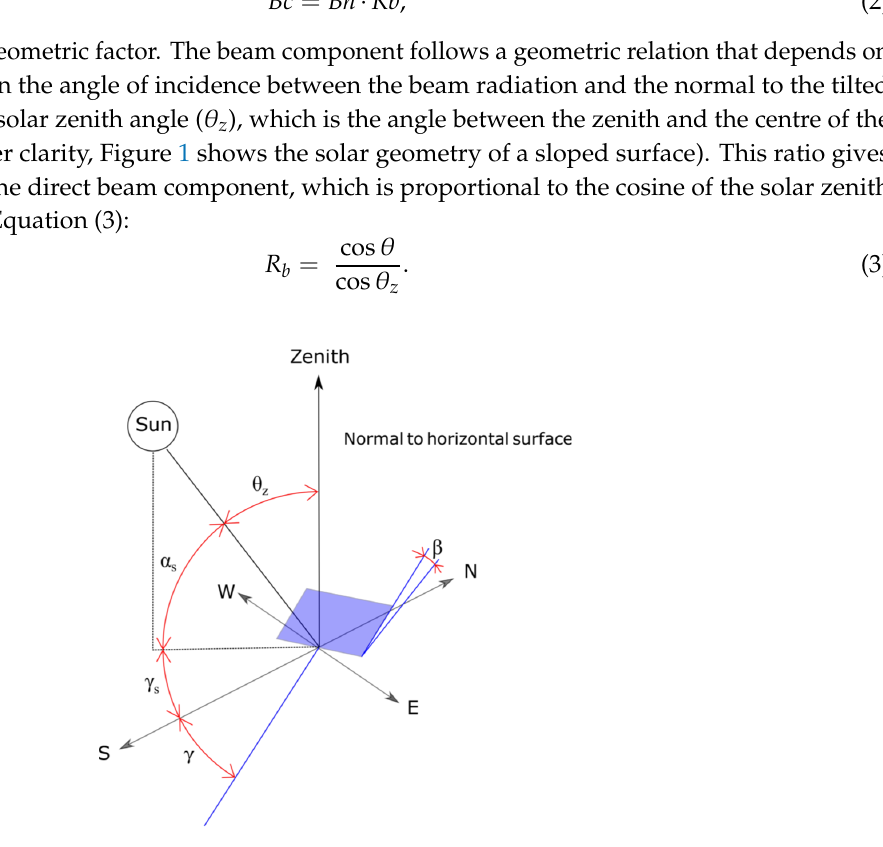
Figure 1. Zenith angle ( θ z ), slope ( β ), surface azimuth angle ( γ ) and solar azimuth angle for a tilted surface ( γ s ).